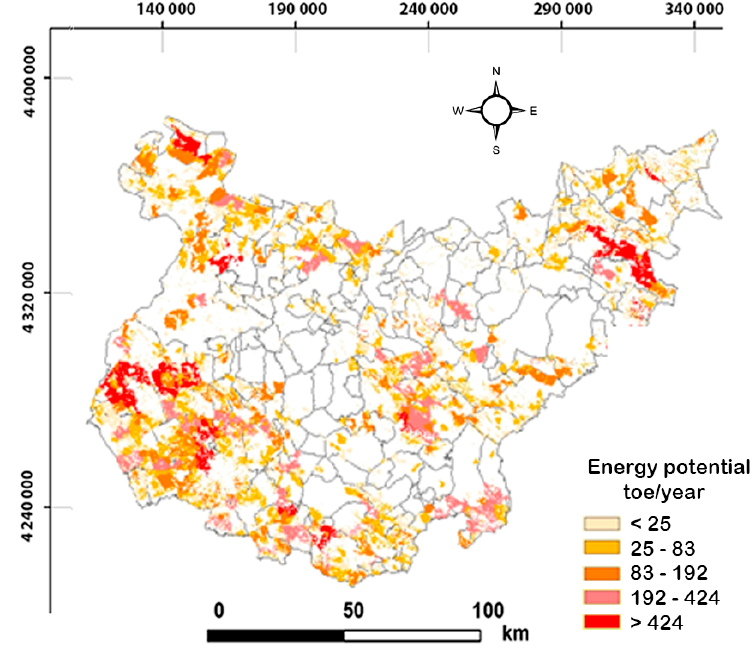
Figure 6. Geographic distribution of the energy potential in the province of Badajoz.